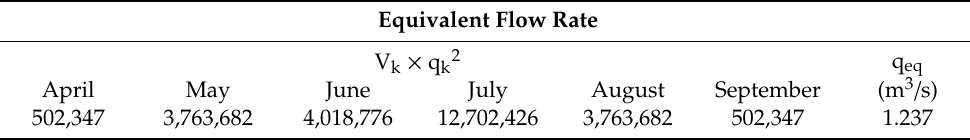
Table 2. Equivalent flow rate calculation from Equation (13).